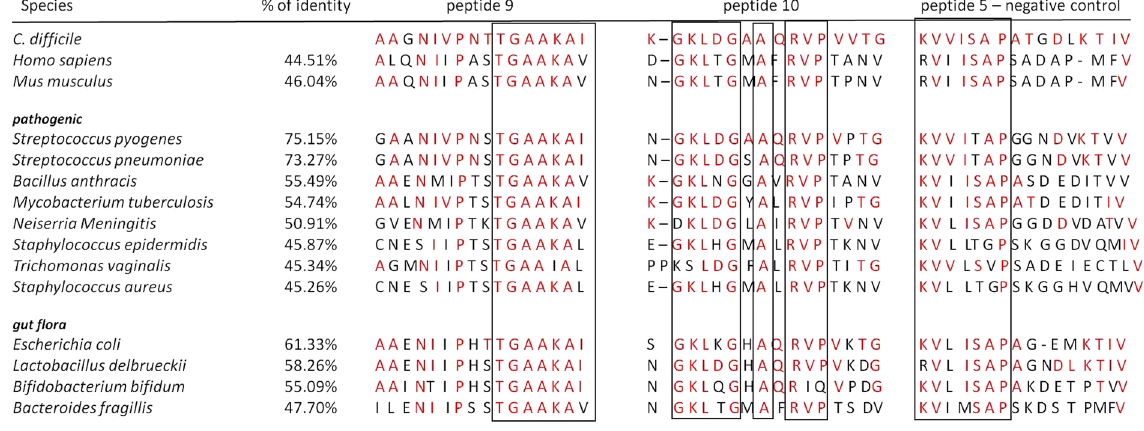
Figure 5. Alignment of Clostridium difficile GAPDH peptide sequences and GAPDH from other species. % identity of GAPDH sequences compared to Clostridum difficile GAPDH sequence. Amino acids in the red are the one shared with C. difficile and selected strains. Sequences in the frames are most conservative between strains. Selected strains include human, mouse, pathogenic strains that express moonlighting GAPDH and most prevalent strains from gut